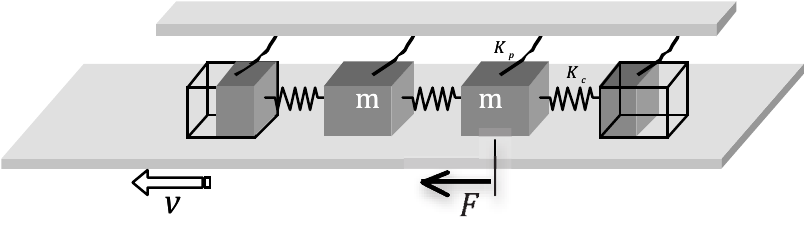
Figure 1. Diagram of the Burridge–Knopoff mechanical model. The system is composed of equal masses ( m ) that are connected to the system by horizontal springs of strength k and vertical springs of strength k . The mass is subjected to the force of friction F ( x ), which only depends on the velocity c p of the block ( V